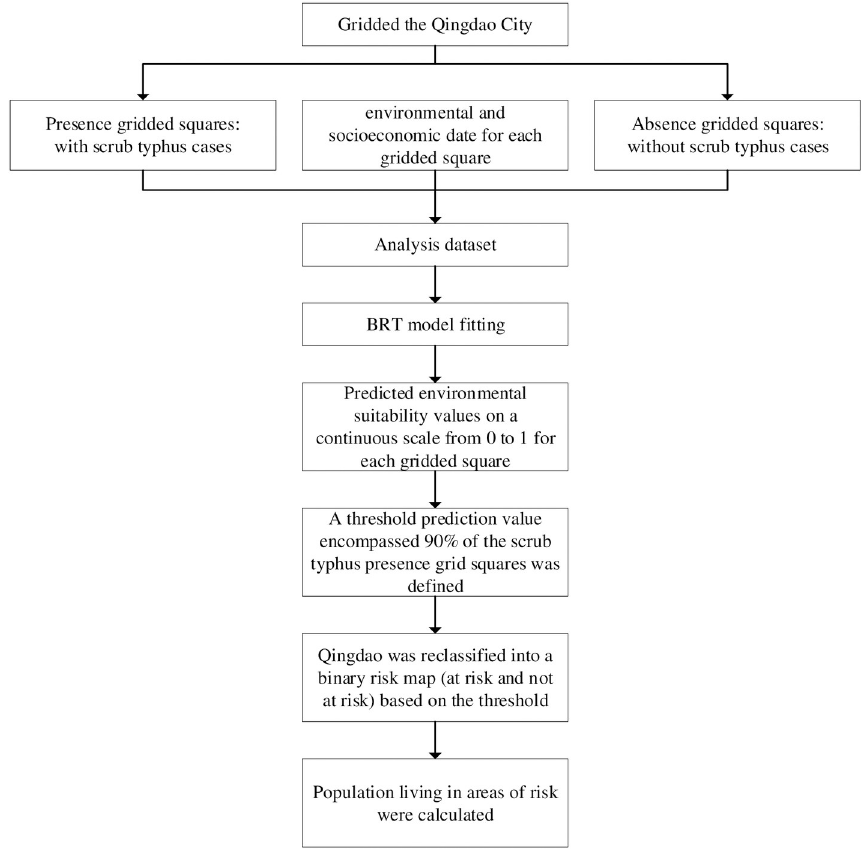
Fig 1. Flow chart of the model